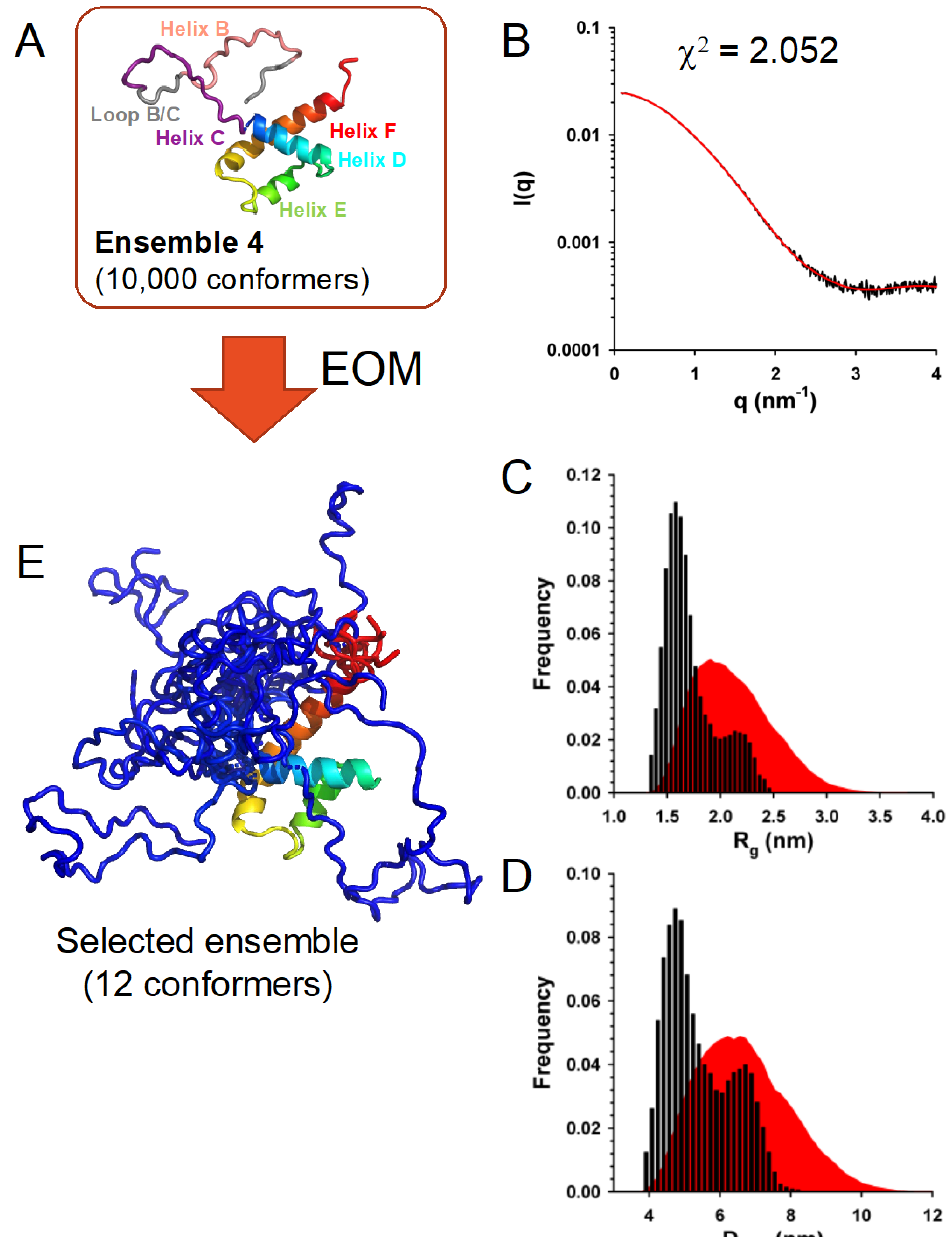
Figure 8. Conformational ensemble modeling of TupV C ∆ 53 protein from SAXS data. ( A ) Description of the initial ensemble, which is comprised of 10,000 conformers in which the regions corresponding to the helix B (in pink), the helix C (in purple), and the loop connecting them (in grey) were allowed to adopt random conformations. ( B ) Experimental SAXS curve for TupV C ∆ 53 (in black) and fitted curve (in red) calculated for one representative ensemble of conformers selected with the program GAJOE (shown in panel ( E )). ( C ) Rg distribution for an ensemble of 12 conformers of TupV C ∆ 53 . The red area shows the distribution for the initial ensemble of conformers. The black bars show the Rg distribution for selected ensembles of 12 conformers. ( D ) D max distribution for an ensemble of 12 conformers of TupV C ∆ 53 . The red area shows the distribution for the initial ensemble of conformers. The black bars show the D max distribution for selected ensembles of 12 conformers. ( E ) Representative ensemble of 12 conformers that reproduced the experimental SAXS curve. The N-terminal disordered part is shown in blue and the structured domain is shown in color from blue to red going from N to